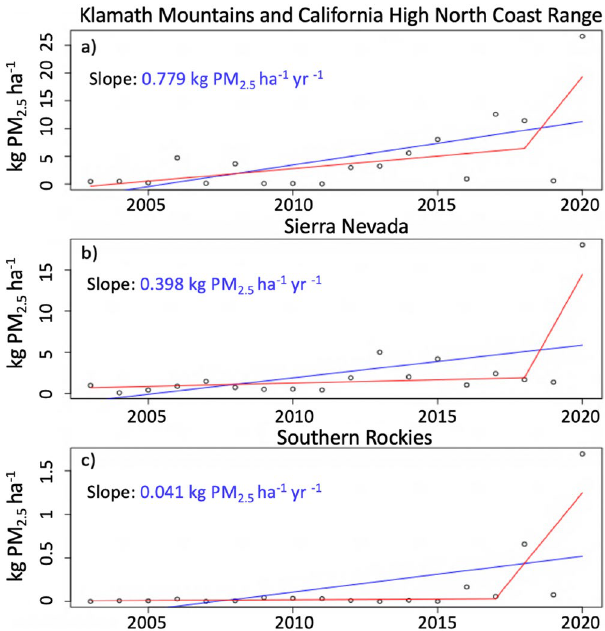
Figure 3. Results of linear (blue) and hinge fit (red) trend analyses for the PM 2.5 mass injected above the PBL within the ( a ) Klamath Mountains and California High North Coast Range, ( b ) Sierra Nevada, and ( c ) Southern Rockies ecoregions. The slope associated with linear trends is listed in